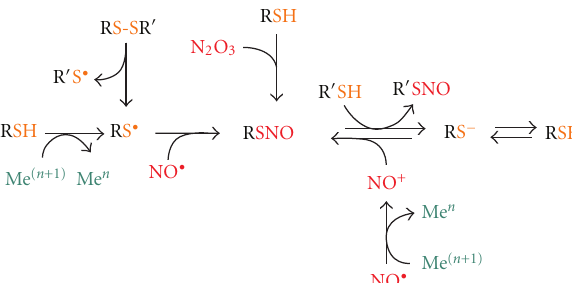
Figure 1: Mechanisms of S -nitrosylation. Cysteines of low molecular weight (e.g., GSH) and protein sulfhydryls (both termed as RSH) can undergo S -nitrosylation, thus generating S -nitrosothiols (RSNO), by di ff erent reactions involving di ff erent NO groups and di ff erent thiol substrates. RSNO can be formed upon the encountering of NO • with a thiyl radical (RS • ), with the latter species deriving from an RSH upon metal-catalyzed oxidation or upon homolytic scission of a disulfide bridge (RS-SR (cid:2) ) (on the left). However, as SH • is a rare and chemically unstable species, it is plausible to consider that the majority of cellular RSNO generates from the thiolate form of the cysteine (RS − ) that can result from sulfur deprotonation even at physiological pH. Either as RS − , or directly as RSH, cysteine sulfhydryl can undergo nitrosylation by reacting with NO-derived dinitrogen trioxide (N 2 O 3 ), or directly with nitrosonium ion (NO + ) generated upon metal-catalyzed oxidation of NO • . The net transfer of NO + from an RSNO to an R (cid:2) S − (transnitrosylation) also occurs inside the cells and represents a further reaction to produce S -nitrosylated adducts (on the